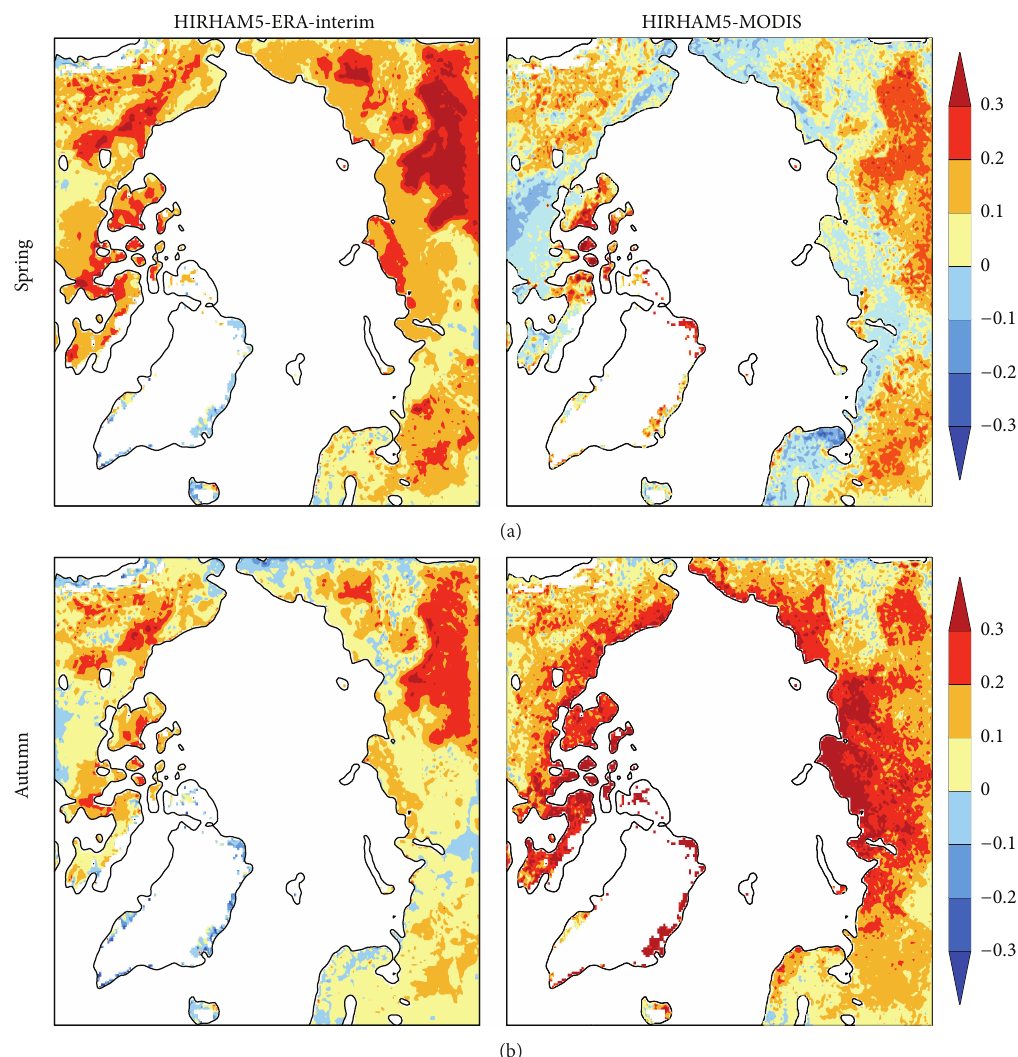
Figure 7: Surface albedo differences “HIRHAM5 minus ERA-Interim” and “HIRHAM5 minus MODIS” for spring (a) and autumn (b), averaged over